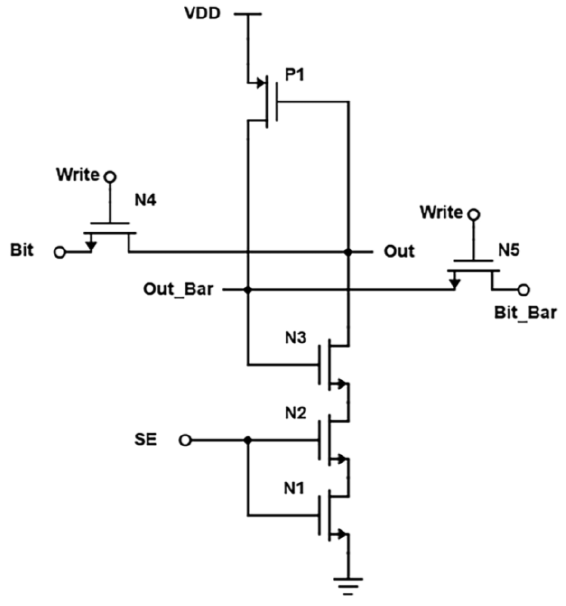
Figure 18. Schematic of Proposed design (Modified Cross-Coupled SRAM).